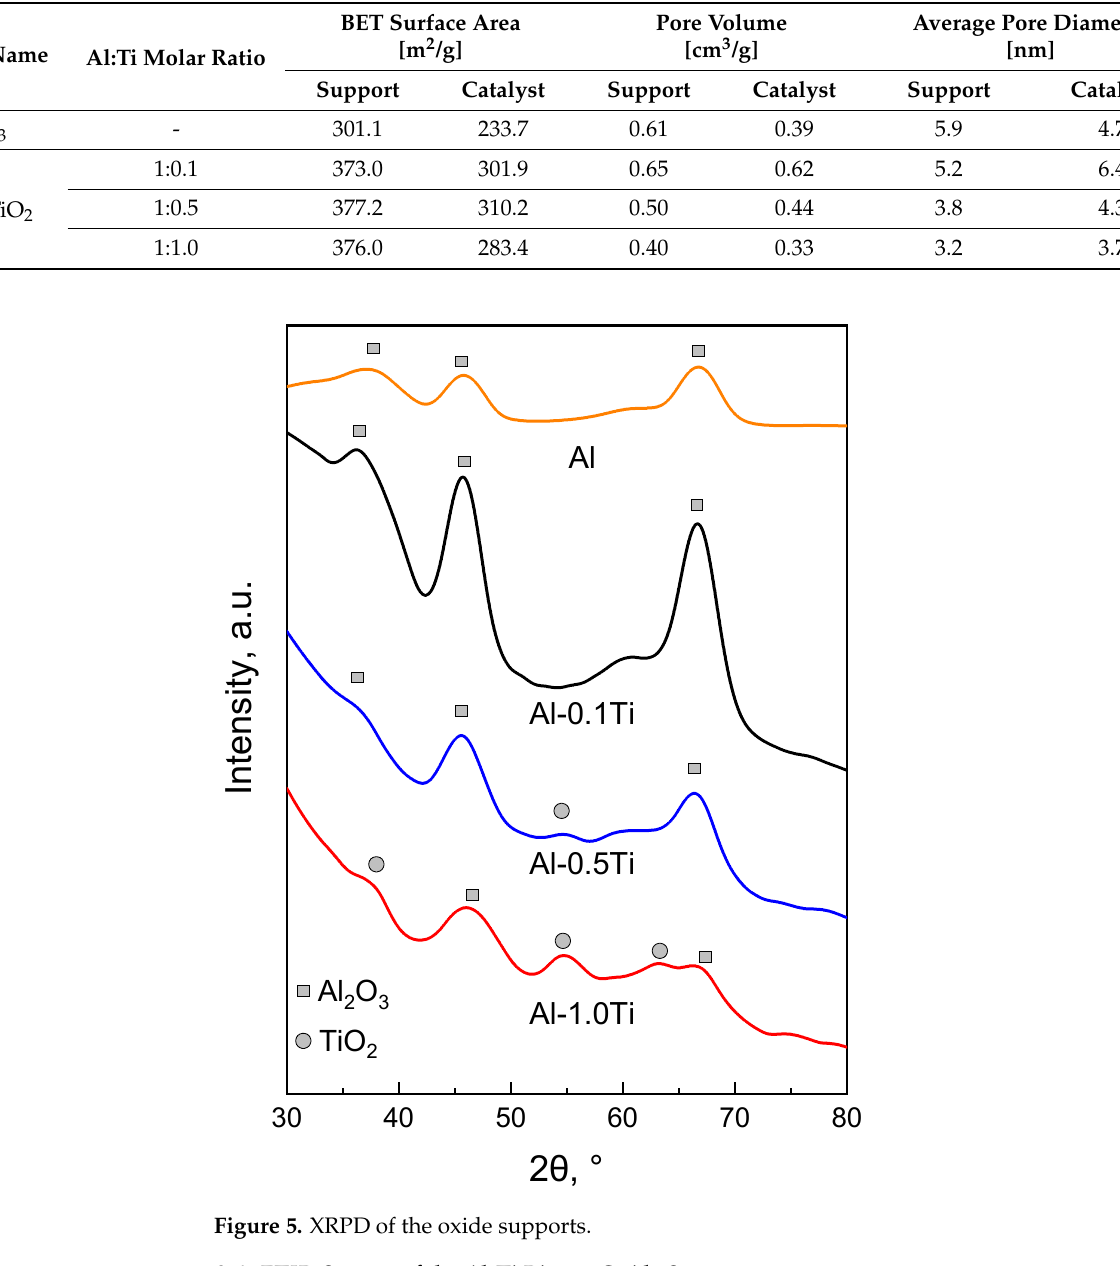
Table 2. BET surface area, pore volume and average pore diameter of oxide supports and platinum catalysts.